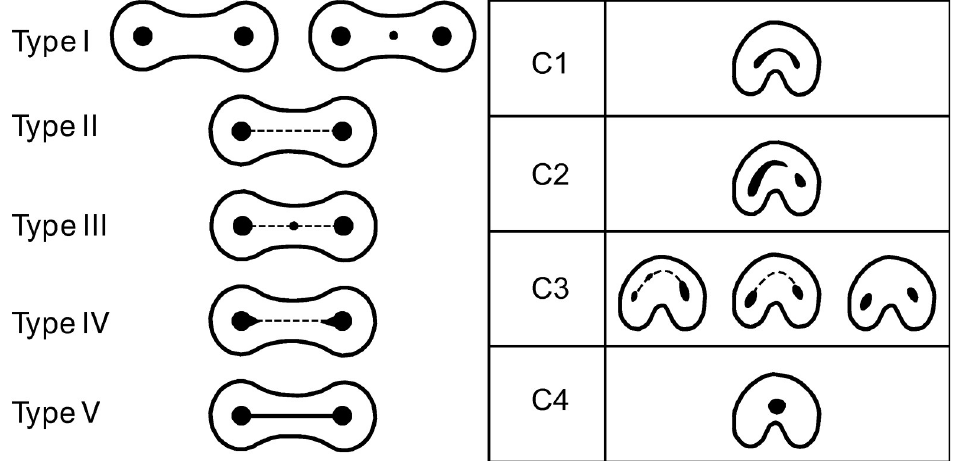
Fig 6. Two different classification methods for canal isthmuses. Left: Canal isthmuses, modified from Hsu and Kim [57]. Right: C-shaped root canals, modified from Fan et al., [11].